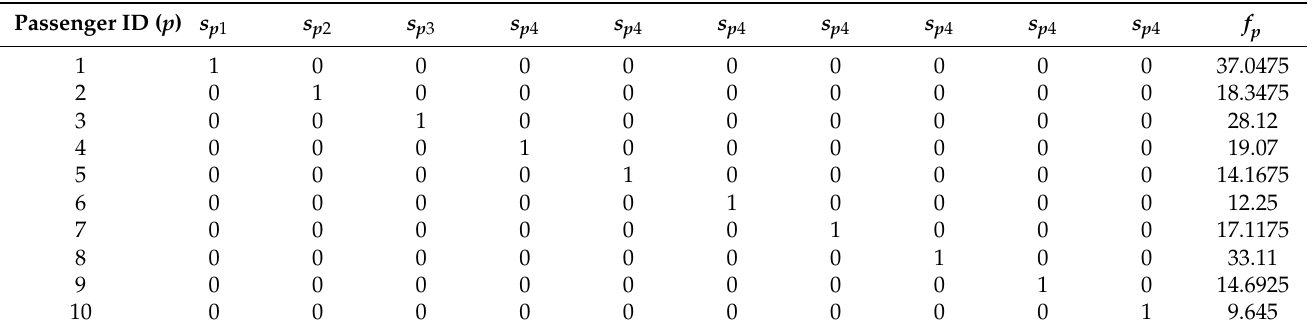
Table 9. Bids submitted by Passengers.